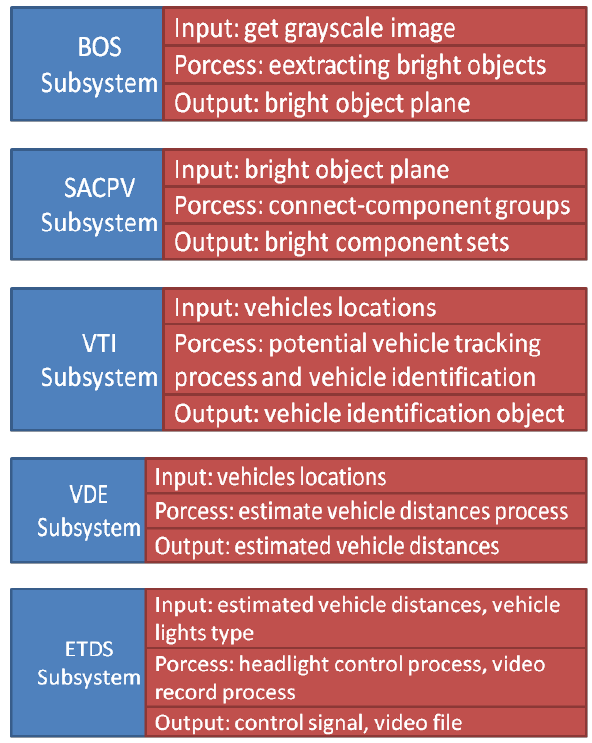
Figure 11. Software modules of the proposed VIDASS